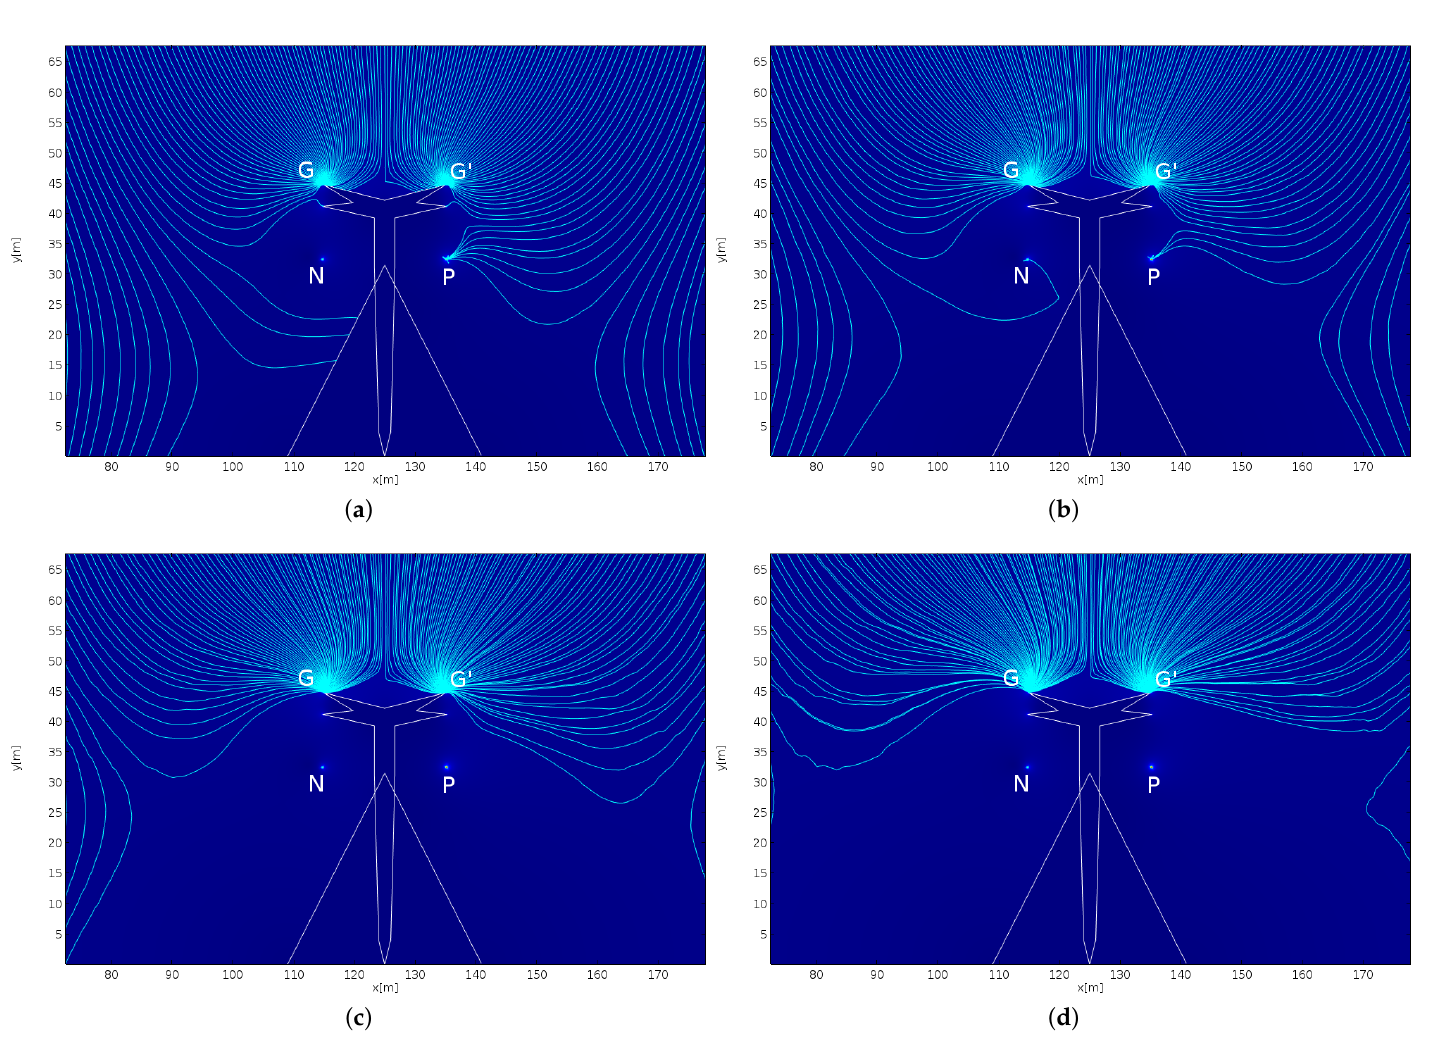
Figure 10. Lightning incidence on the tower plane as given by EFD model. ( a ) I p = 2.9 kA, ( b ) 5.4 kA, ( c ) 10.1 kA and ( d ) 15.7